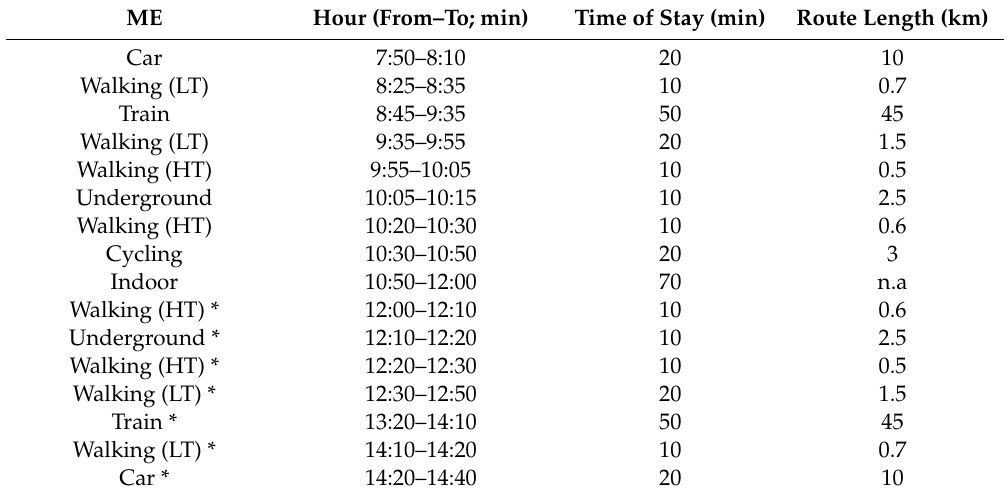
Table 1. Summary of the micro-environments (MEs) considered in this study. Hour and time of stay refers to those a priori planned, even if small variations should be considered. (LT: low-traffic condition; HT: high-traffic condition; n.a.: not available). * Return trip—these MEs refer to the same MEs frequented during the first part of the journey.